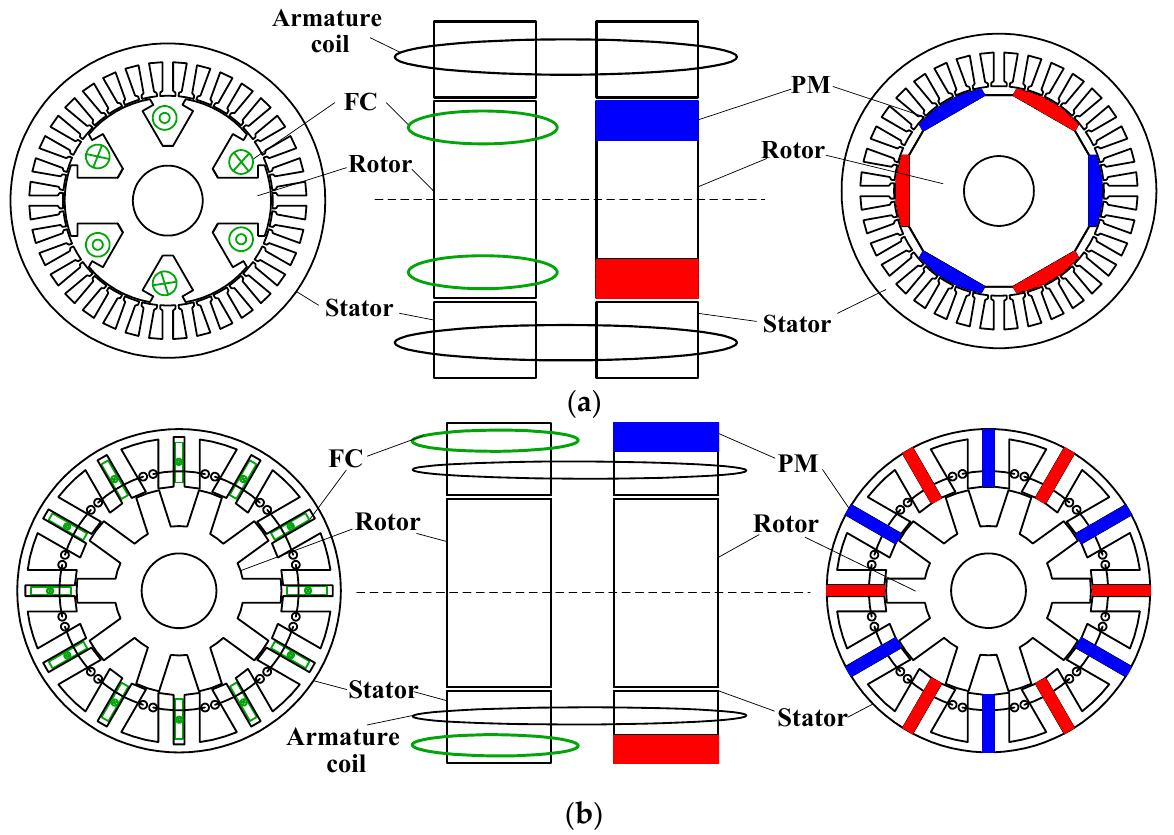
Figure 11. Configurations of dual stack HE machines with parallel couplings. ( a ) Dual ‐ stack HE machine with wound ‐ field rotor and PM rotor [54]. ( b ) Dual ‐ stack HE machine with wound ‐ field stator and PM stator [56].